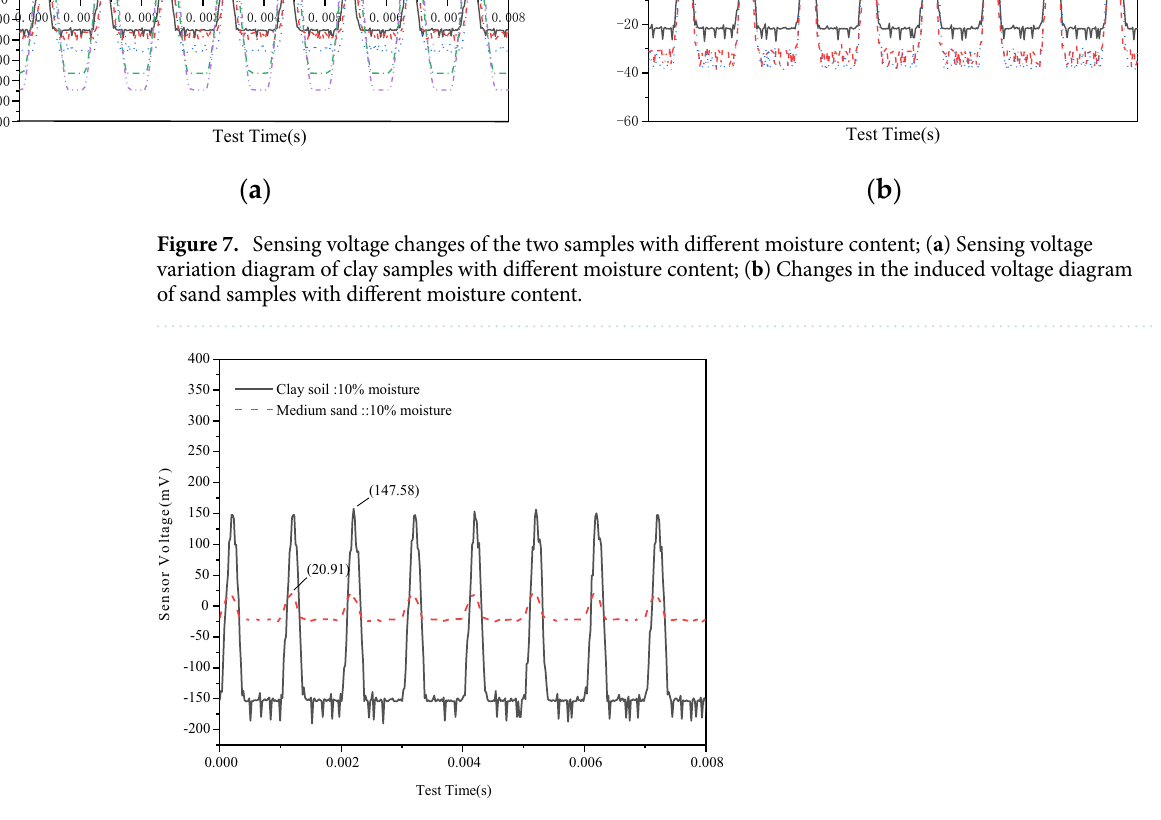
Figure 8. Energy waveform of different samples with the same moisture